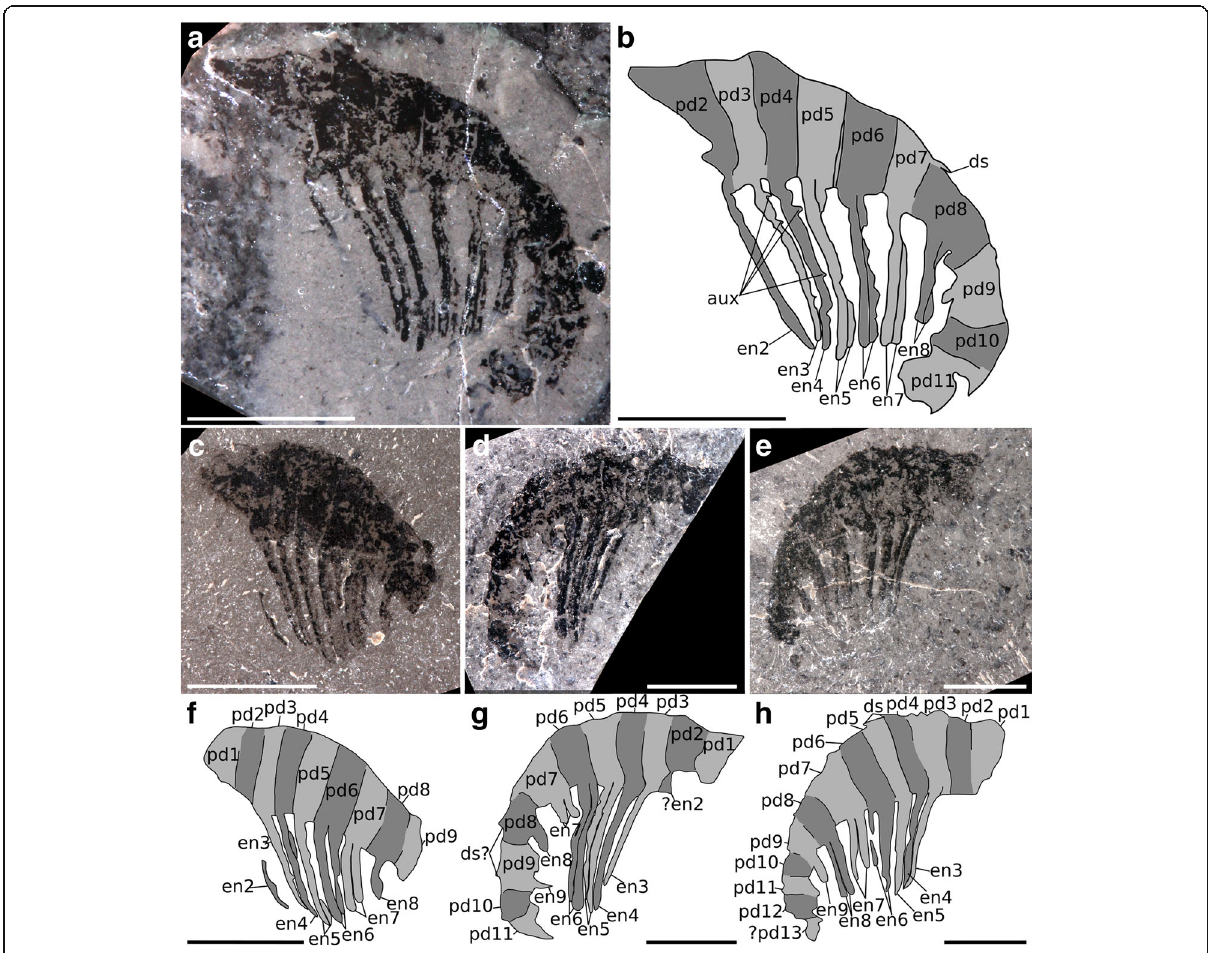
Fig. 4 Ursulinacaris grallae appendages from the Mount Cap Formation, Northwest Territories, Canada. a and b GSC 140185. c and f GSC 135494a. d and g GSC 140186a. e and h GSC 140184. Abbreviations: aux, auxiliary spine; ds, dorsal spine; en, endite; pd, podomere. Scale bars = 5 mm